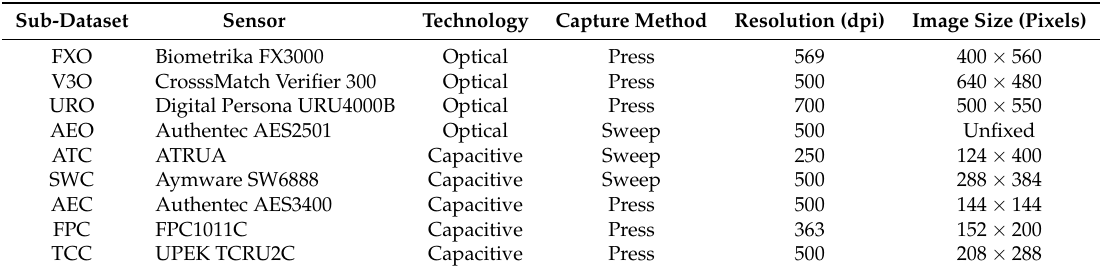
Table 1. Summary of the FingerPass